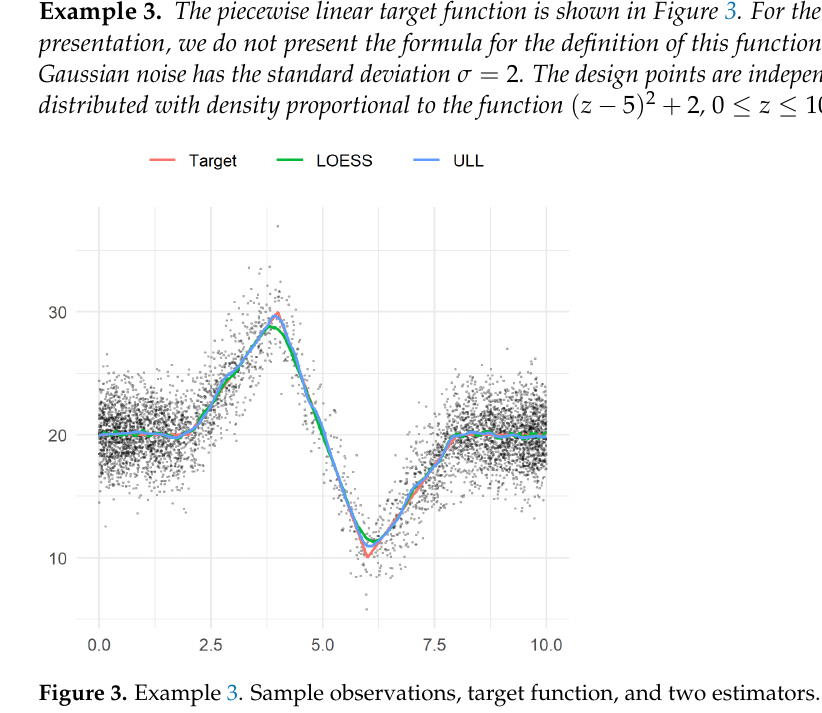
Figure 3. Example 3. Sample observations, target function, and two